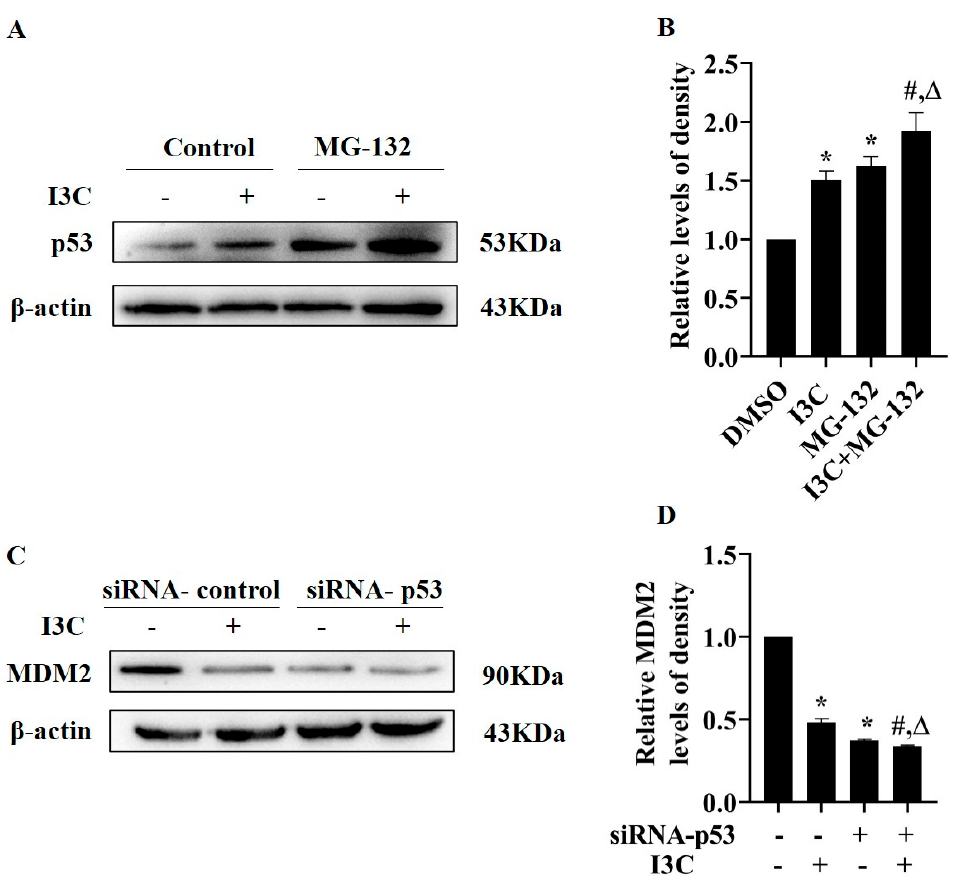
Figure 7. The effect of I3C on the stabilization of p53 by MDM2. ( A ) The effect of combined I3C and MG-132 on the expression of p53; ( B ) Densitometric analysis for blots shown in ( A ). * p < 0.05 VS. DMSO, # p < 0.05 vs. I3C, Δ p < 0.05 vs. MG-132; ( C ) The effect of I3C on MDM2 expression in siRNA- p53 transfection cells; ( D ) Densitometric analysis for blots shown in ( C ). * p < 0.05 VS. siRNA- control+DMSO, # p < 0.05 vs. siRNA-control+I3C, Δ p < 0.05 vs. siRNA-p53+DMSO.